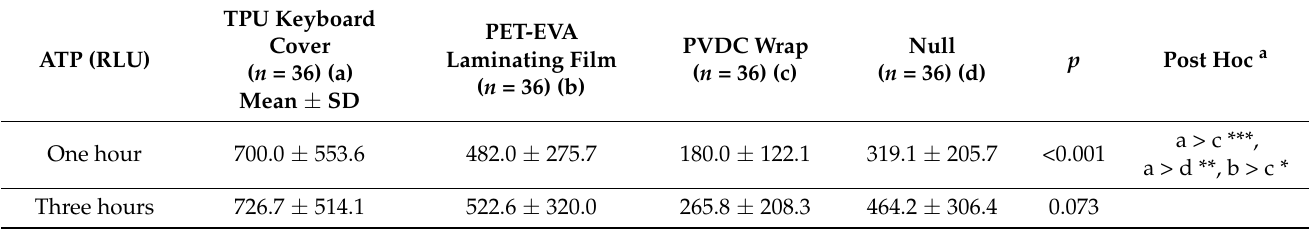
Table 1. Comparison of ATP values on different plastic materials and uncovered panel (null) ( n = 144).